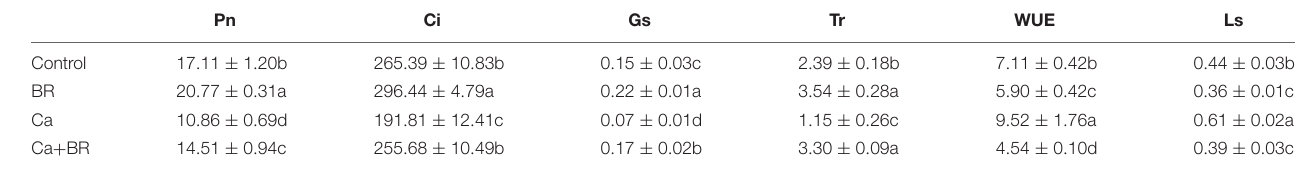
TABLE 1 | Effects of exogenous BR on the photosynthetic parameters in the leaves of tomato seedlings under Ca(NO 3 ) 2 stress. Pn Ci Gs Tr WUE Ls